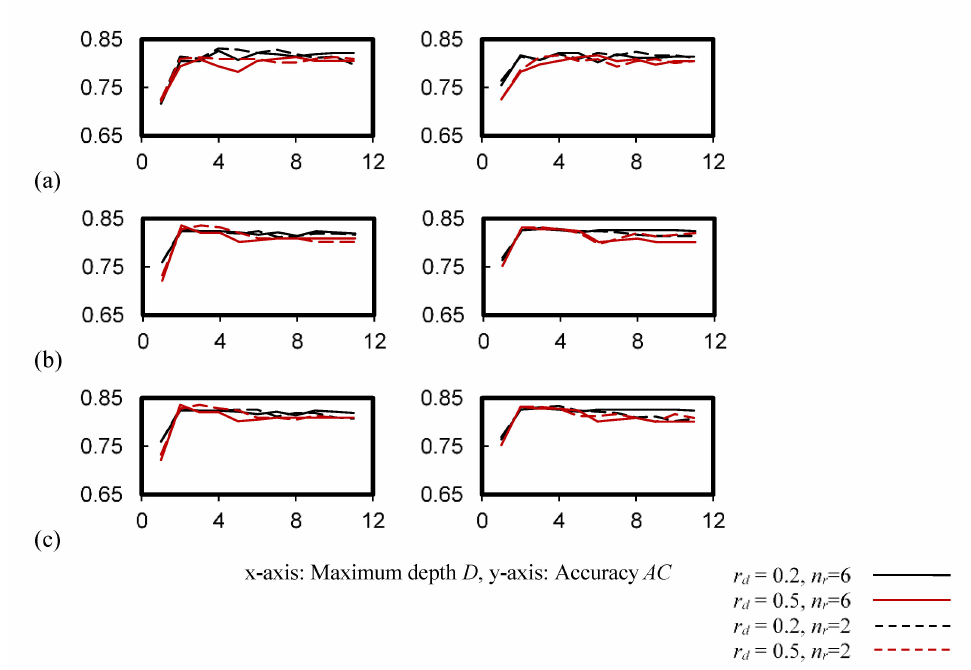
Figure 7. Cross-validation accuracy of the random forest classifier. ( a ) Entropy impurity, n s = 9, n f = 10 ( b ) Gini impurity, n s = 9, n f = 110, ( c ) Gini impurity, n s = 2, n f =